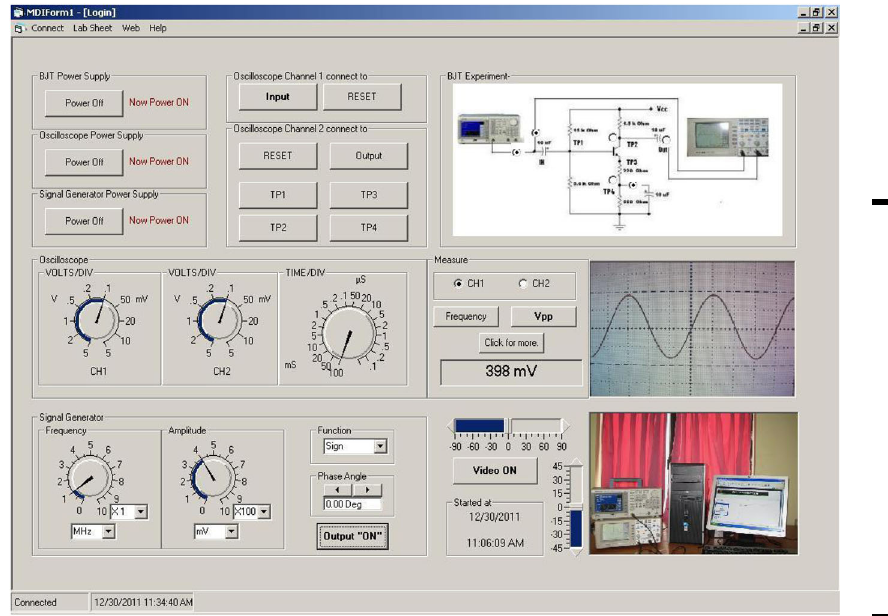
Figure 7. User interface of the ORL client